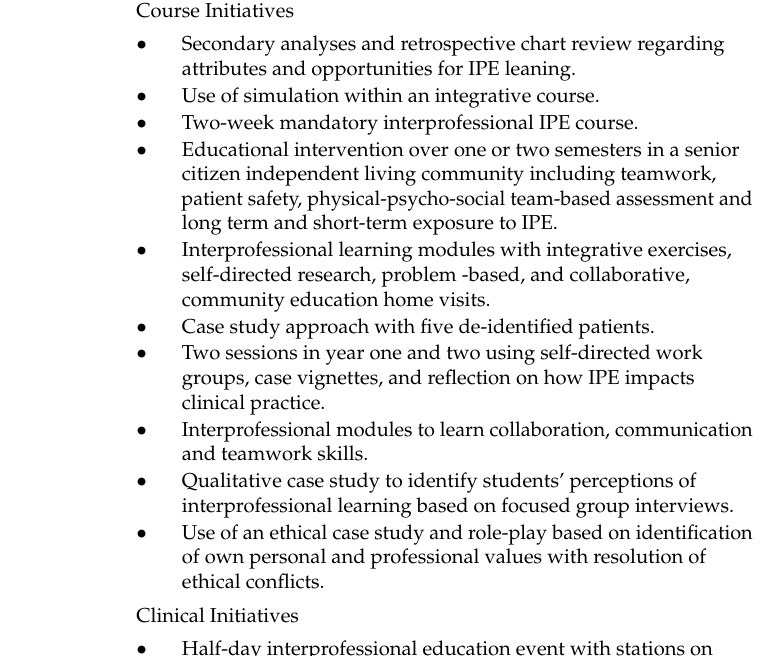
Table 2. Cont. Course